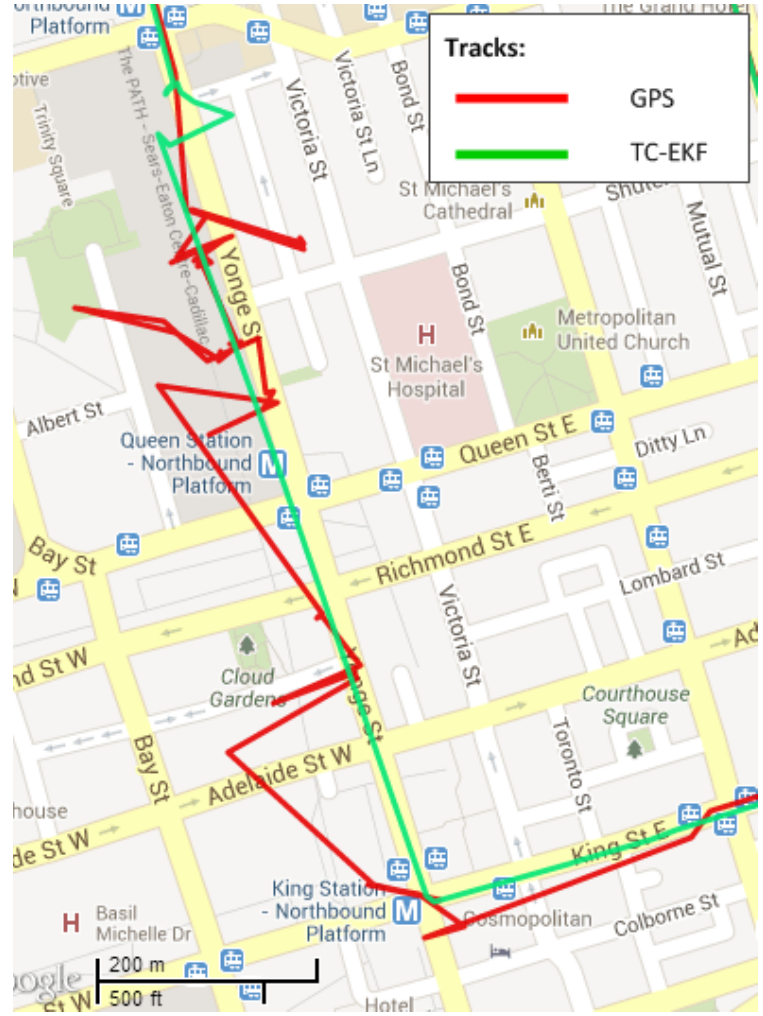
Figure 18. Performance in noisy and jeopardized GPS signal conditions during outage